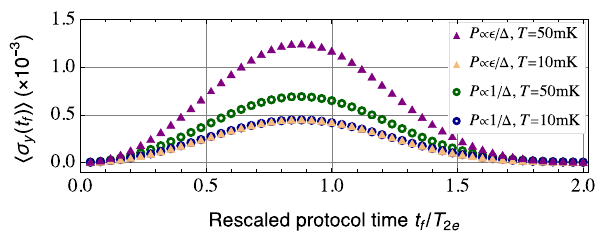
Fig. 4 Numerically simulated Hahn-echo qubit coherence function h ^ σ y ð t f Þi corresponding to two charge-noise baths. The bath spectral functions are generated by an ensemble of two-level fl uctuators (TLFs) with ^ H ¼ ϵ ^ Σ z þ Δ ^ Σ x , which are coupled to a phonon bath via ^ Σ x (see 49 for TLF details). Two TLF distributions P ( ϵ , Δ ) are used in the simulation: P ( ϵ , Δ ) ∝ ϵ / Δ (triangles), and P ( ϵ , Δ ) ∝ 1/ Δ (circles). The qubit – bath coupling strength is chosen such that the qubit coherence time is T 2e = 1 μ s at T = 10 mK (orange triangles and blue circles). As we increase bath temperature to T = 50 mK, the two models predict qualitative difference in the behavior of the Hahn-echo signal h ^ σ y ð t f Þi (purple triangles and green circles), which in turn encodes dynamics of the quench phase